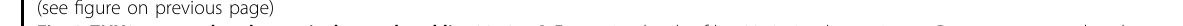
Mut group (Fig. 7A). qRT-PCR and western blot results